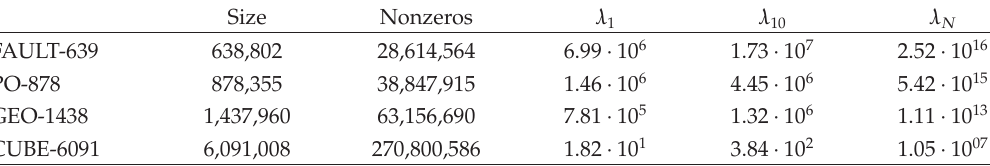
Table 1: Size, number of nonzeros, and three representative eigenvalues of the test matrices. Size Nonzeros λ 1 λ 10 λ